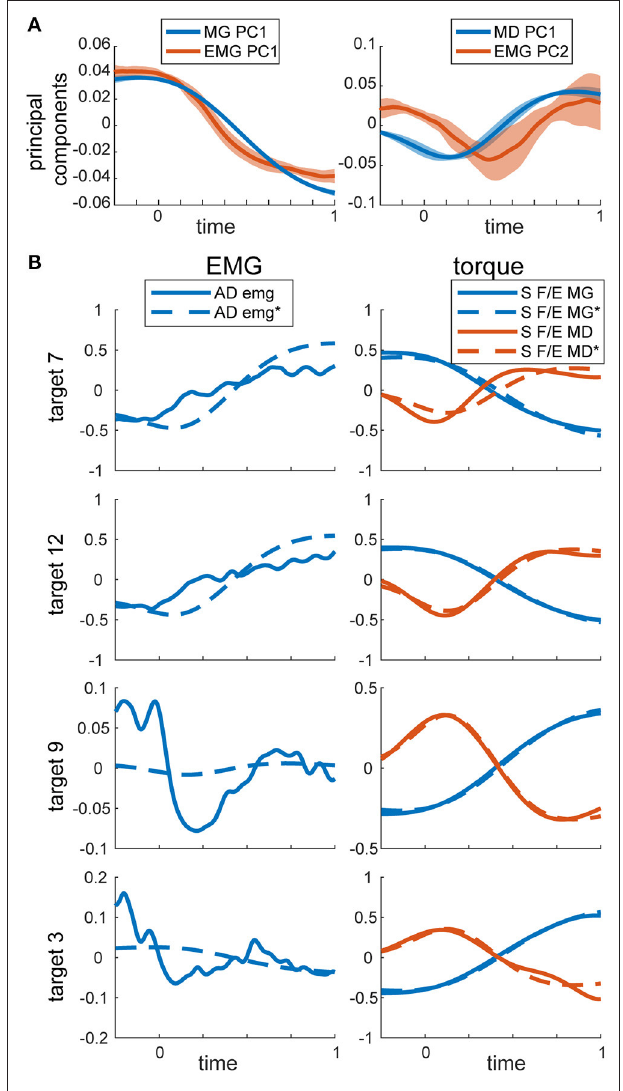
FIGURE 3 | PCA on torques and EMG. (A) Temporal activation profiles of EMG and torque components. Average normalized activation profiles (solid lines) and standard deviations (shaded area) across all subjects are plotted for each eigenvector. (B) Example recorded and reconstructed signals from the same subject and movements as in Figure 2 . MG and MD torques were reconstructed from their respective first principal components only. EMG was reconstructed from the same torque components as described in Methods. MG and MD torques and EMG were normalized and demeaned as described in Methods. Reconstructed signals are labeled with * and marked with dashed lines. S F/E stands for Shoulder flexion/extension